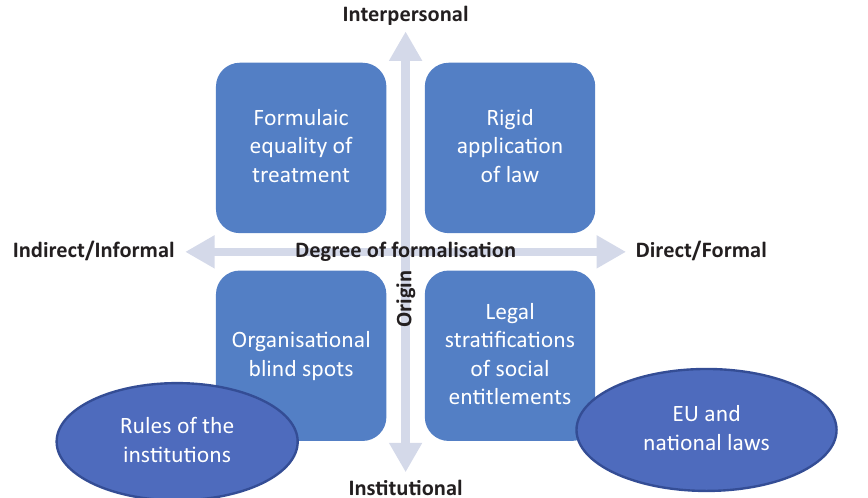
Figure 1. Characterising multi‐level institutional discrimination in local job